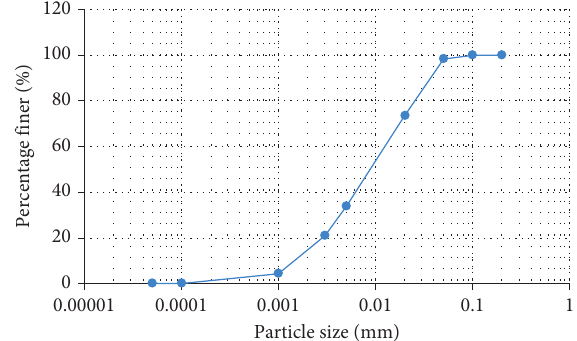
Figure 3: Particle size distribution of the soft soil.